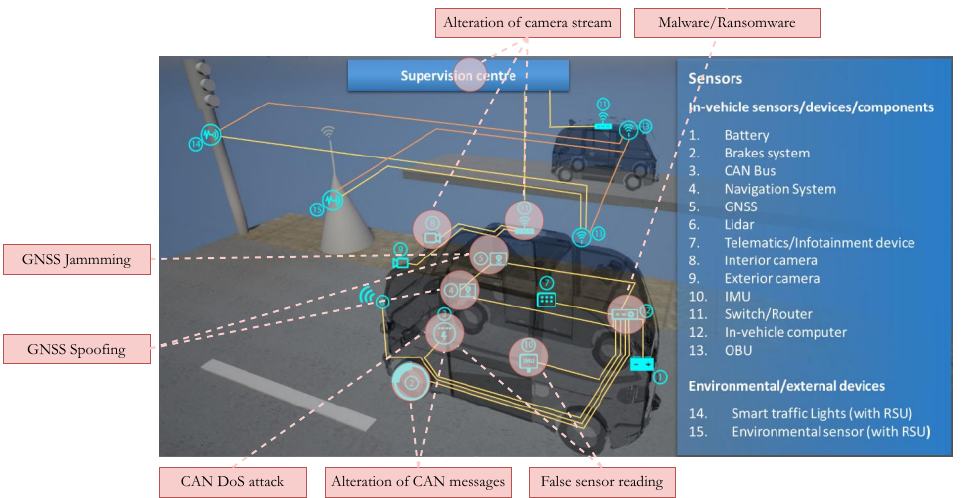
Figure 3. The IoV environment and the compromised components for each attack scenario.